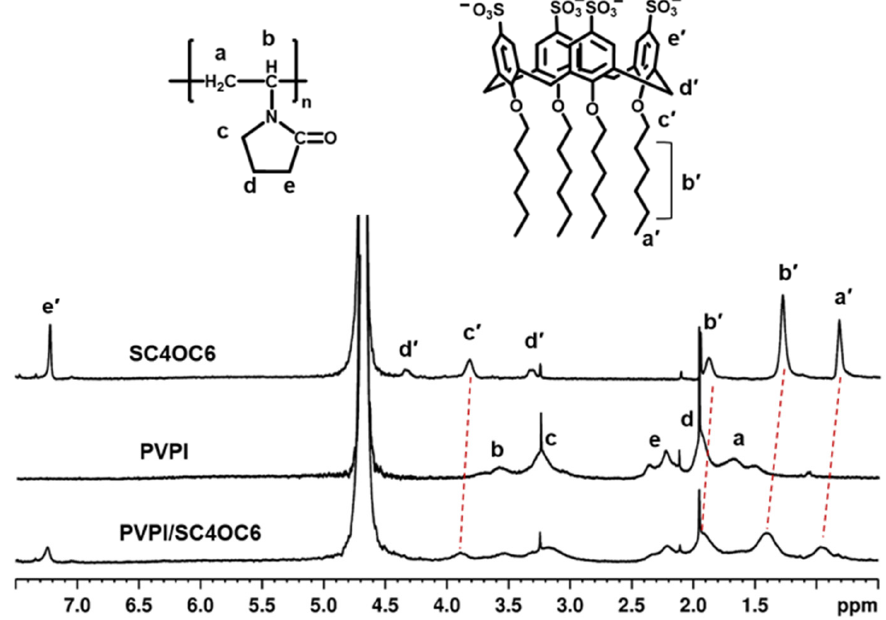
Figure 5. 1 H NMR spectra (400 MHz, D 2 O, 297 K) of SC4OC6, PVPI, and PVPI/SC4OC6.